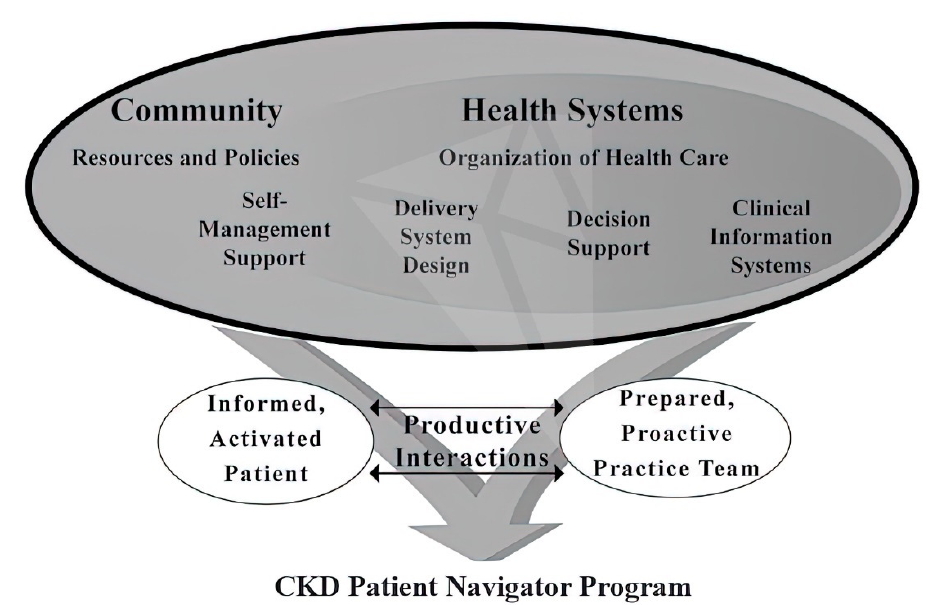
Figure 2. Chronic care model and its relationship with the CKD Patient Navigator Program. Source: Wagner et al. [36,39].